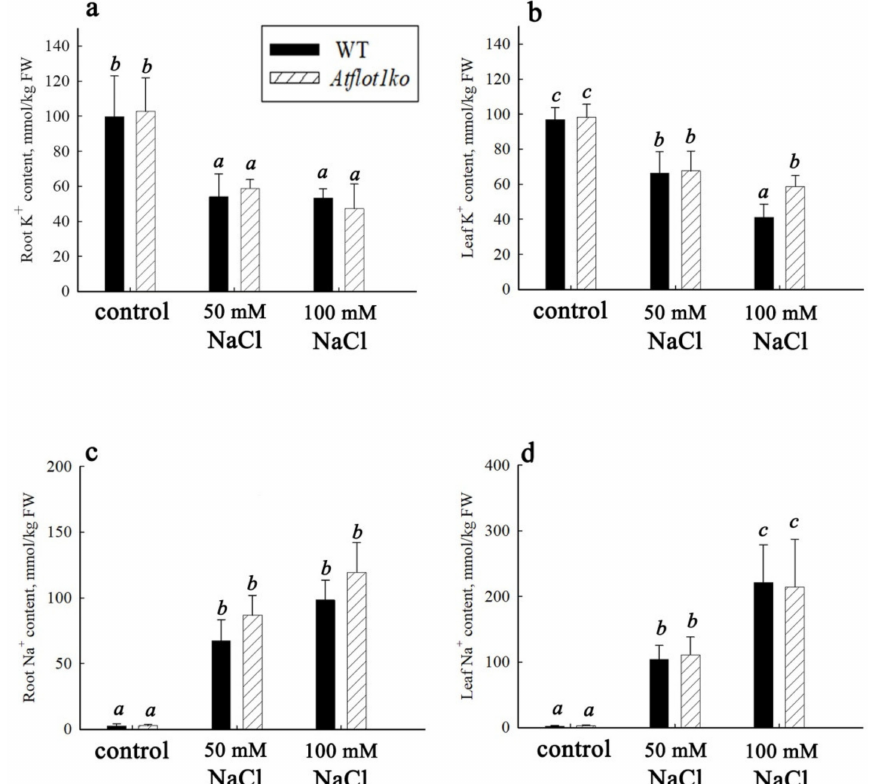
Figure 3. K + ( a , b ) and Na + ( c , d ) content in roots and leaves of A. thaliana WT and Atflot1ko knockout mutant plants grown either in the absence (control) or presence of NaCl in the medium at final concentrations of 50 and 100 mM. Here, ( a , c ) roots, and ( b , d ) leaves. Means ± SE are given ( n = 15). Different letters indicate statistically significant differences between the samples (ANOVA; p <